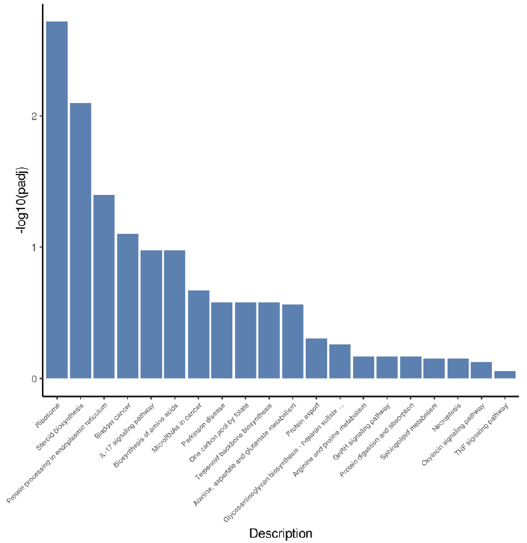
Figure 7. KEGG enrichment pathway of significantly different genes. Different column heights represent the magnitude of enrichment significance of this pathway. Animals 2022 , 12 , x